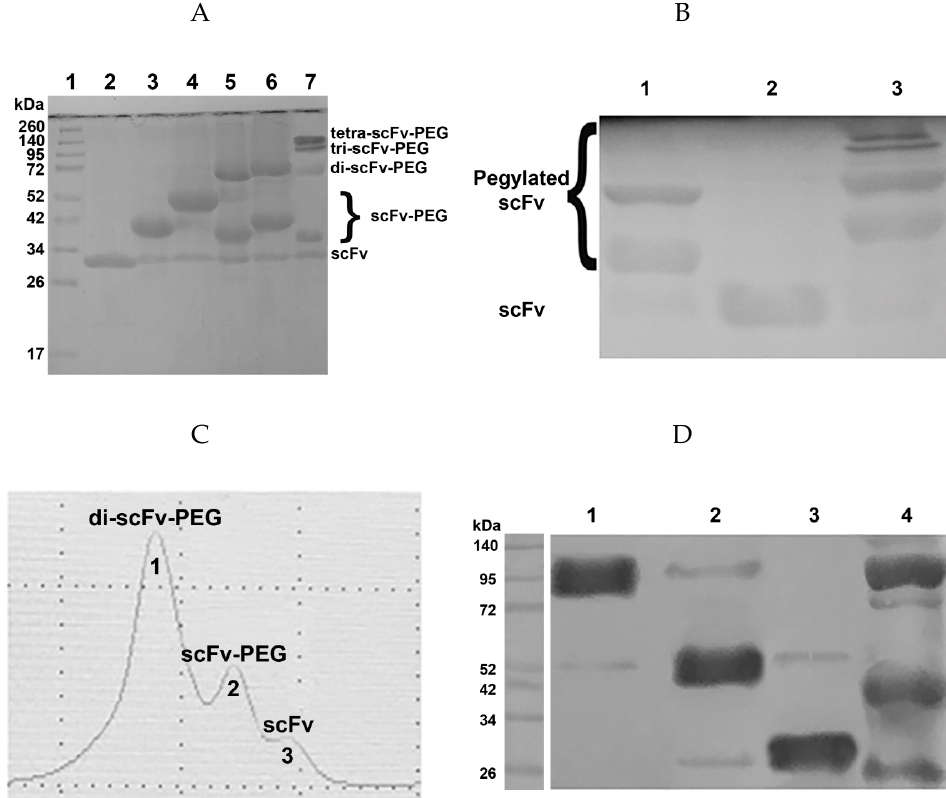
Figure 3. Efficiency of the pegylation reaction. ( A ) 12% SDS-PAGE of the pegylation reaction products; 1, molecular weight protein markers; 2, intact scFv fragments 14.18; 3, pegylation with PEG-maleimide 5 kDa; 4, pegylation with PEG-maleimide 10 kDa; 5, pegylation with PEG-di-maleimide 2 kDa; 6, pegylation with PEG-di-maleimide 5 kDa; 7, pegylation with PEG-tetra-maleimide 10 kDa. ( B ) Western blot of the pegylation reaction products; membrane was incubated with HRP-labelled anti-FLAG antibodies (1:6000); 1, pegylation with PEG-di-maleimide 5 kD; 2, intact scFv fragments 14.18; 3, pegylation with PEG-tetra-maleimide 10 kD. ( C ) size-exclusion chromatographic purification (Superdex 200 10/300 GL column), pegylation reaction with PEG-di-maleimide 5 kD. ( D ) western blot following size-exclusion chromatographic purification, pegylation reaction with PEG-di-maleimide 5 kD; 1, fraction of pegylated di-scFv fragments; 2, fraction of pegylated mono-scFv fragments; 3, fraction of non-pegylated scFv fragments; 4, total protein mixture after pegylation with PEG-di- maleimide 5 kD.